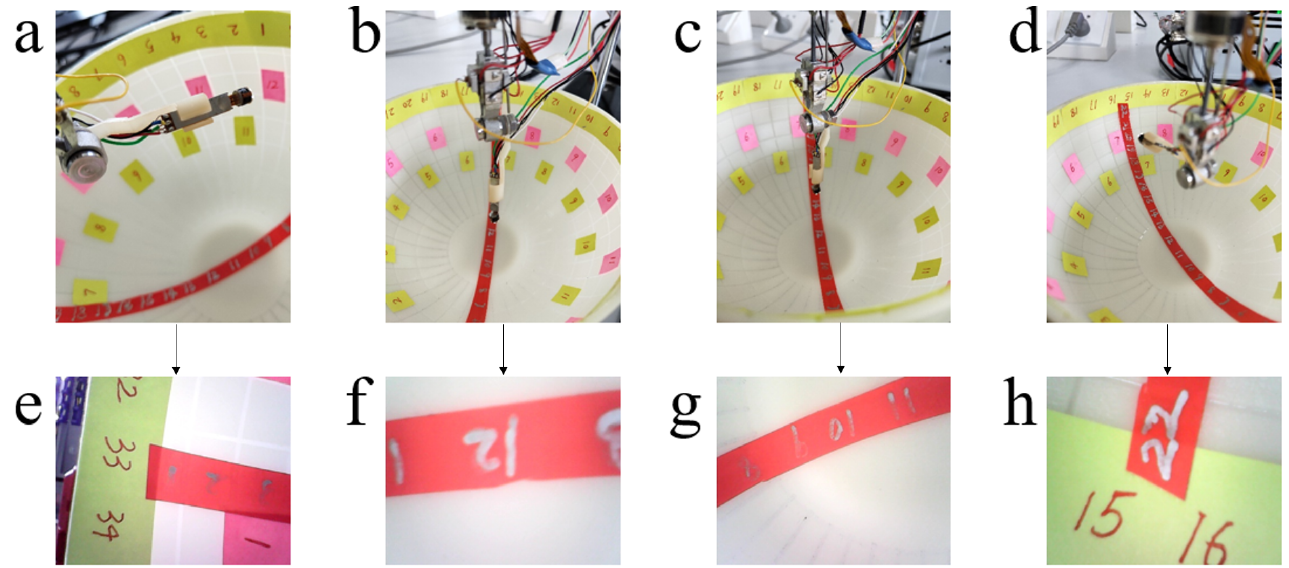
Figure 18. Laparoscopic motions and images. ( a ) The laparoscope is driven to tilt 90 ◦ ; ( b ) the laparoscope is driven to tilt 90 ◦ in reverse; ( c ) the laparoscope is driven to extend 17mm; ( d ) the laparoscope is driven to rotate one turn; ( e ) the picture taken when the laparoscope is driven to tilt 90 ◦ ; ( f ) the picture taken when the laparoscope is driven to tilt 90 ◦ in reverse; ( g ) the picture taken when the laparoscope is driven to extend 17mm; ( h ) the picture taken when the laparoscope is driven to rotate one